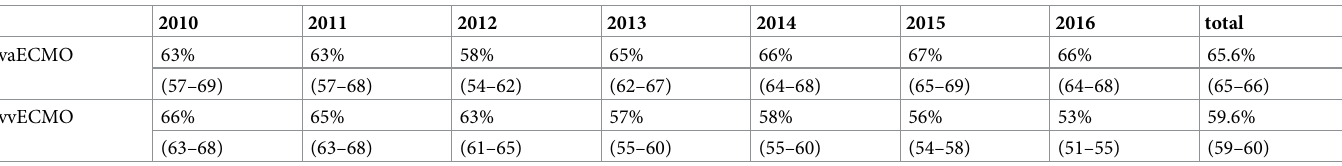
Table 3. Mortality (95% CI) for vvECMO and